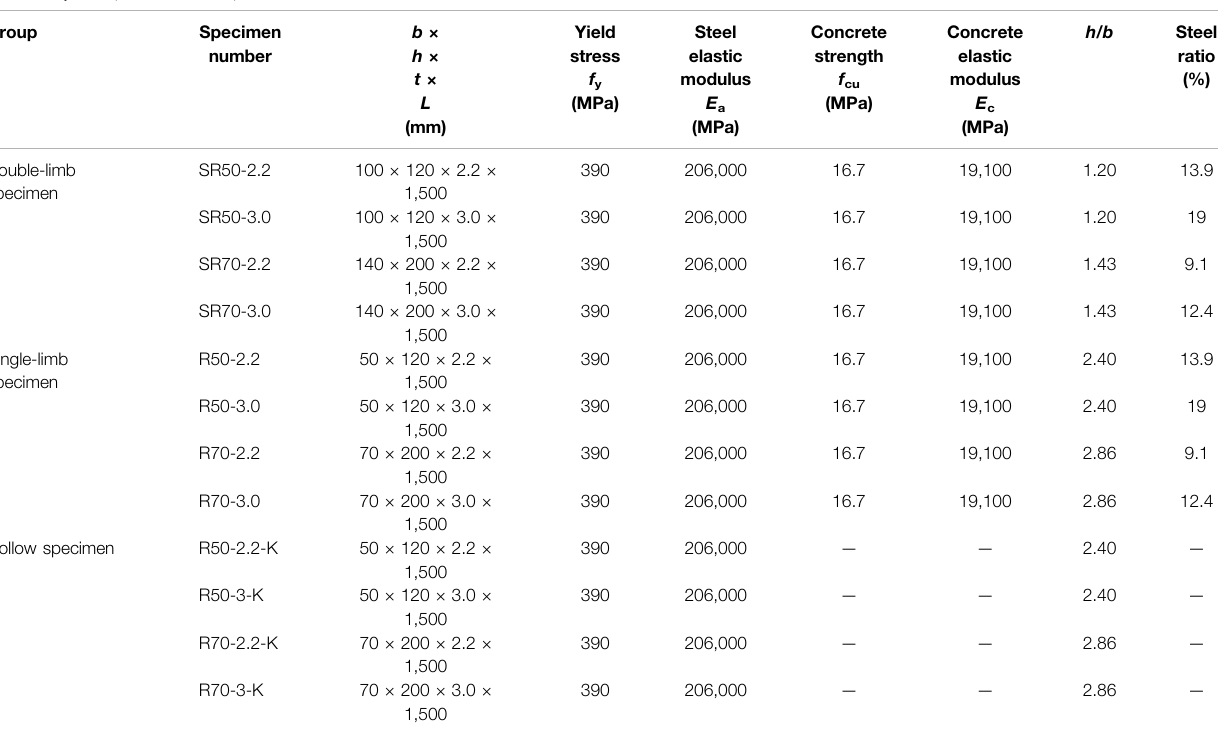
TABLE 1 | Main parameters of